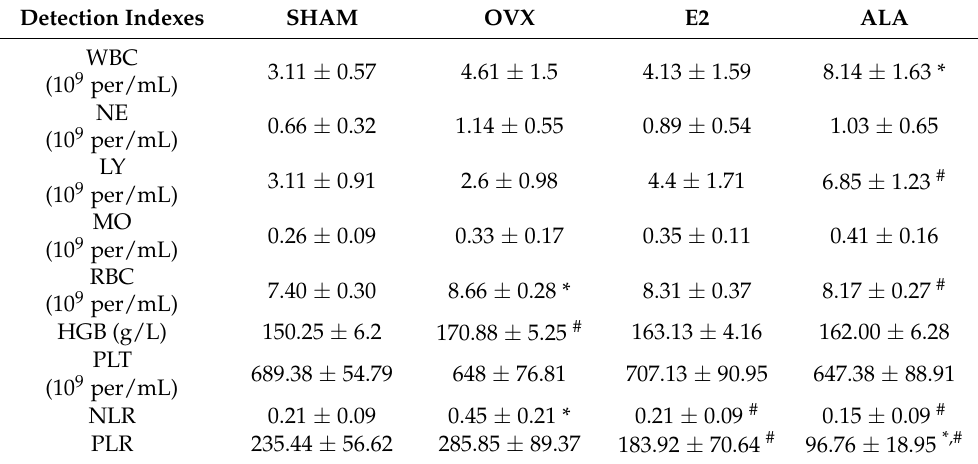
Table 3. Routine blood indexes in different rat groups with preventive intervention. Detection Indexes